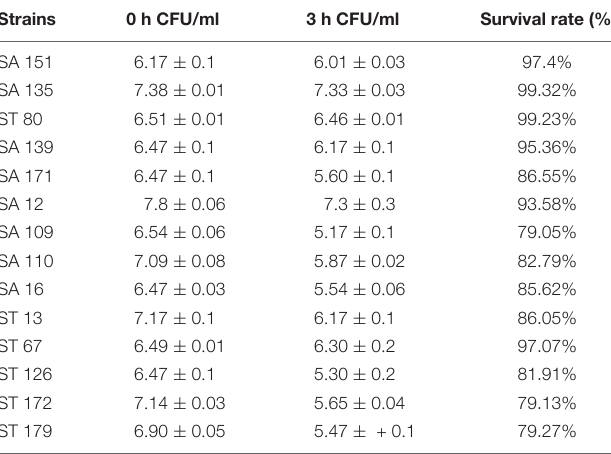
TABLE 2 | Acid tolerance and survival rate of selected isolates under acidic conditions.